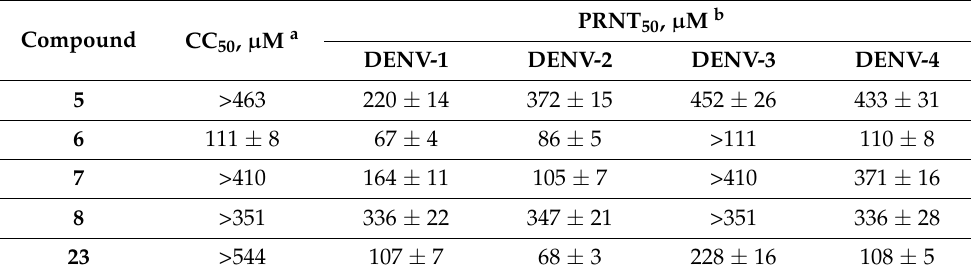
Table 2. The anti-Dengue activity of compounds 5 – 8 and 23